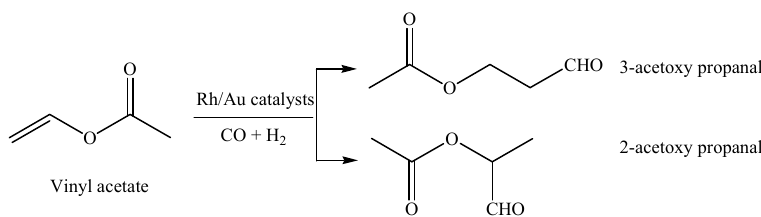
Scheme 1. Schematic diagram of vinyl acetate hydroformylation using prepared catalysts.